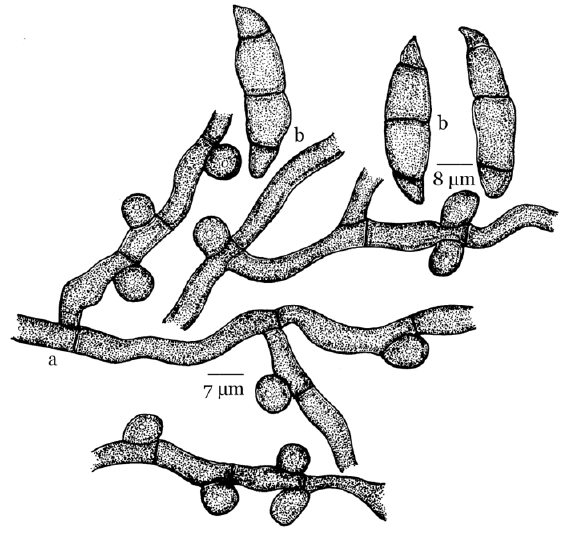
Figure 184. Questieriella strychni a - Appressoriate mycelium; b - Conidia of Questieriella